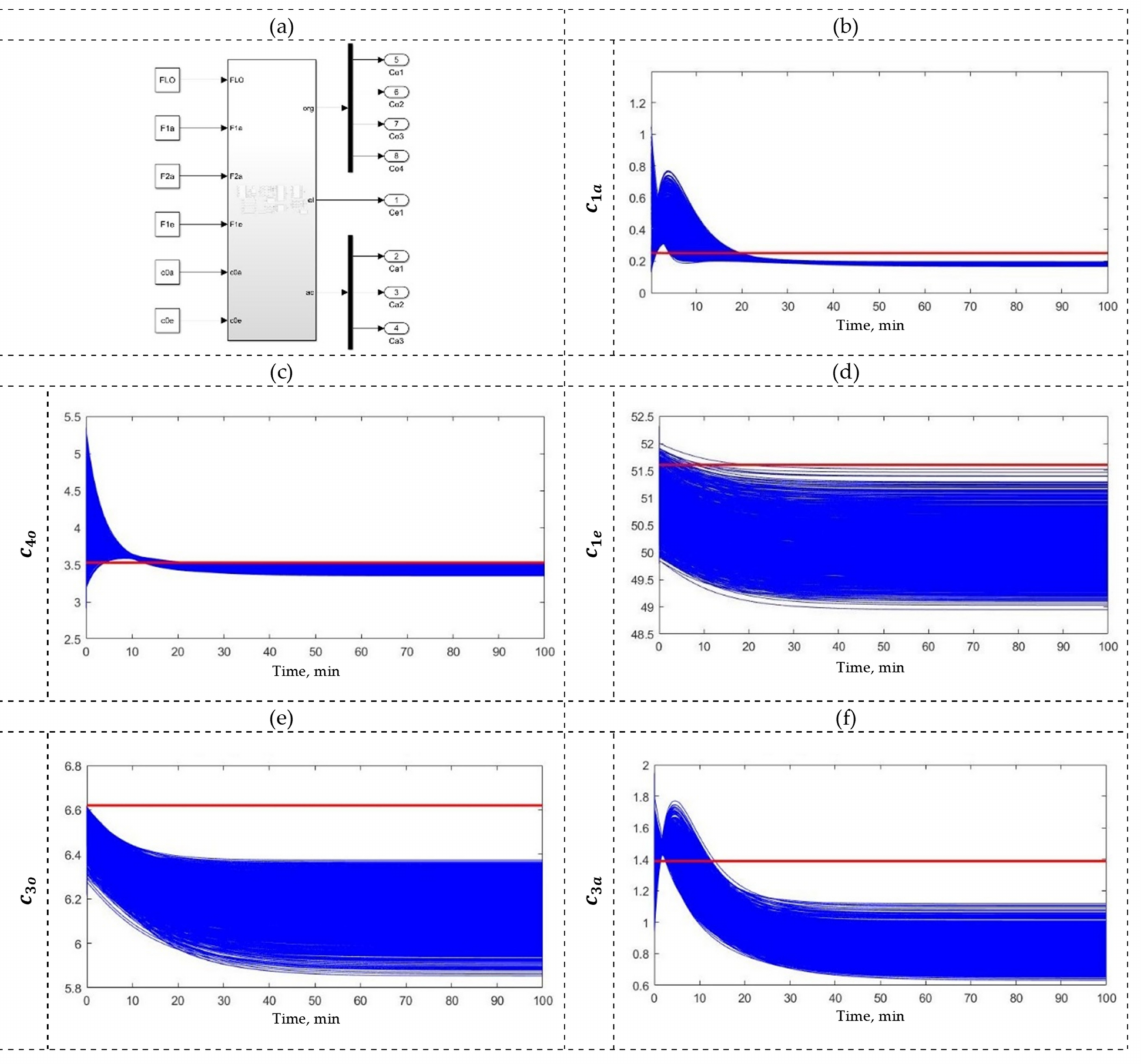
Figure 9. ( a ) SX plant as a MIMO system, and UA results using ( b ) c 1 a , ( c ) c 4 o , ( d ) c 1 e , ( e ) c 3 o , and ( f ) c 3 a as output